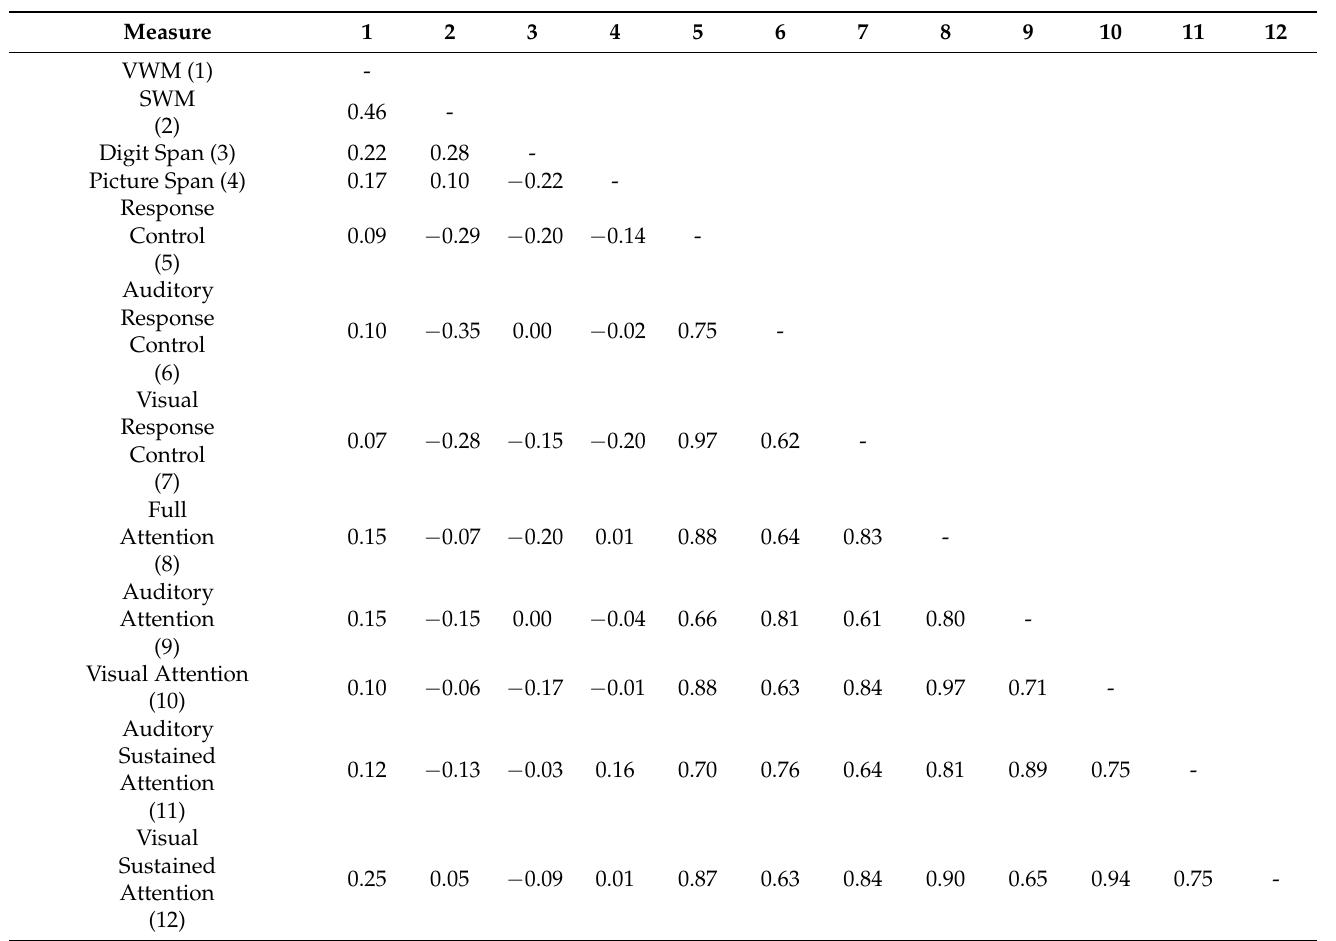
Table 2. Correlations among pre-test measures of